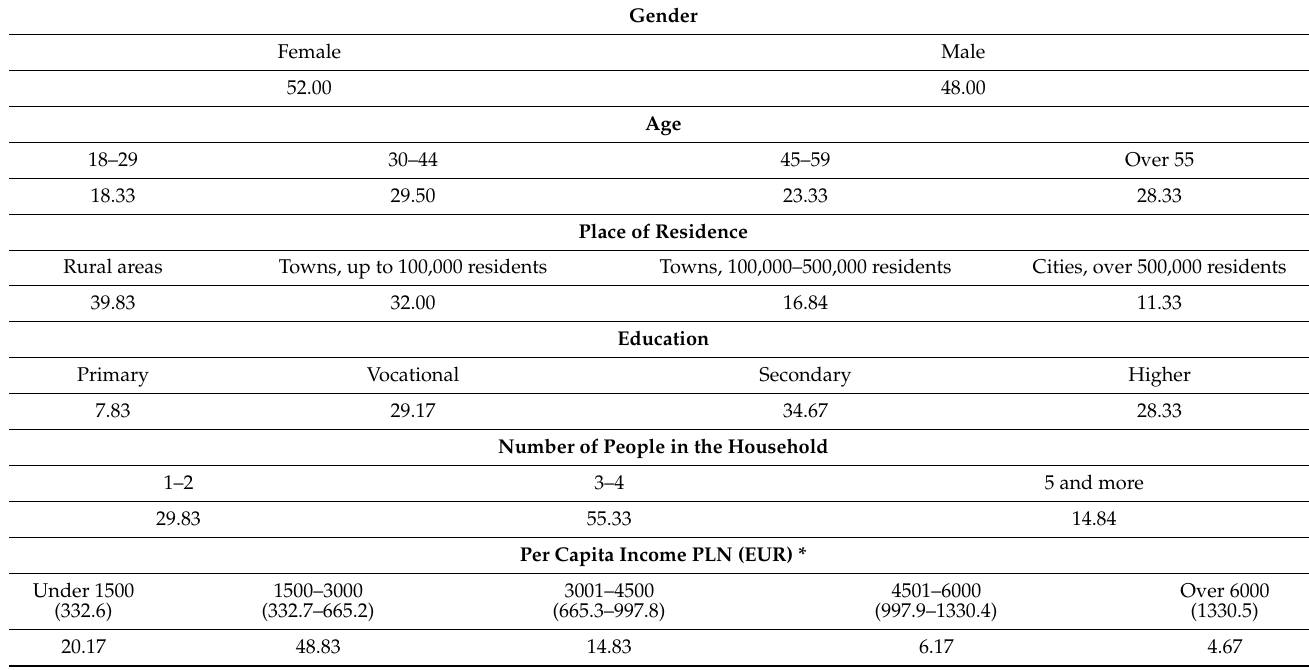
Table 1. Sample characteristics